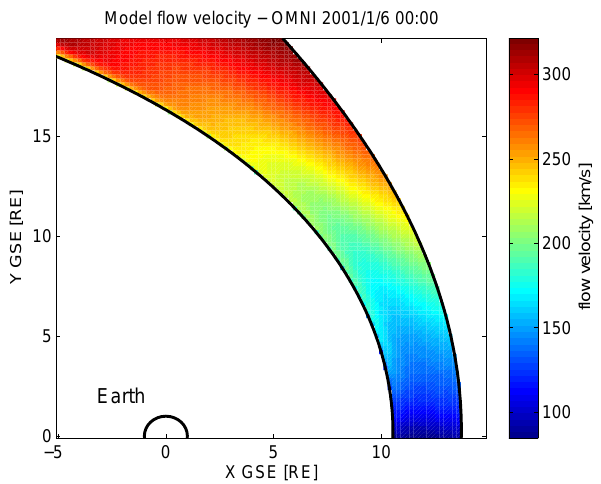
Fig. 4. Color-coded flow speed in GSE equatorial plane calcu- lated from the model. Upstream conditions from 1 June 2001, 00:00UT were chosen for this example, being close to average solar wind parameters: V u = 410kms − 1 , | n u | = 4 . 5 cm − 3 , | B u | = 7 . 2 nT, M A = 6 . 1, and β = 0 .